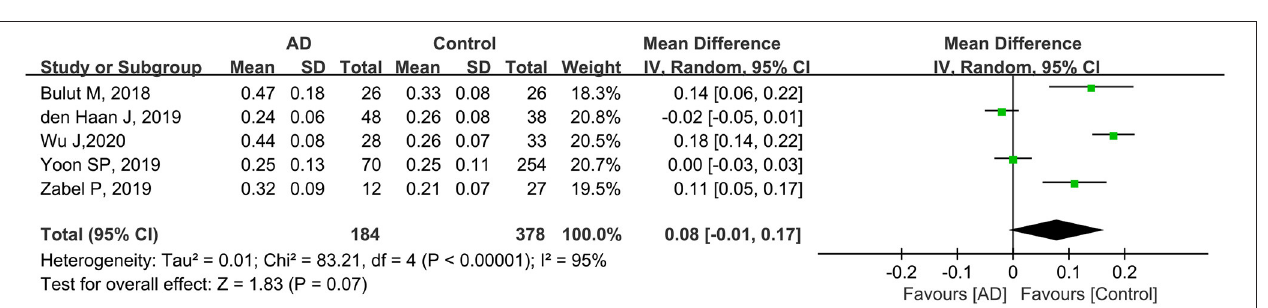
FIGURE 8 | Forest plot for analysis of foveal avascular zone in eyes with AD and